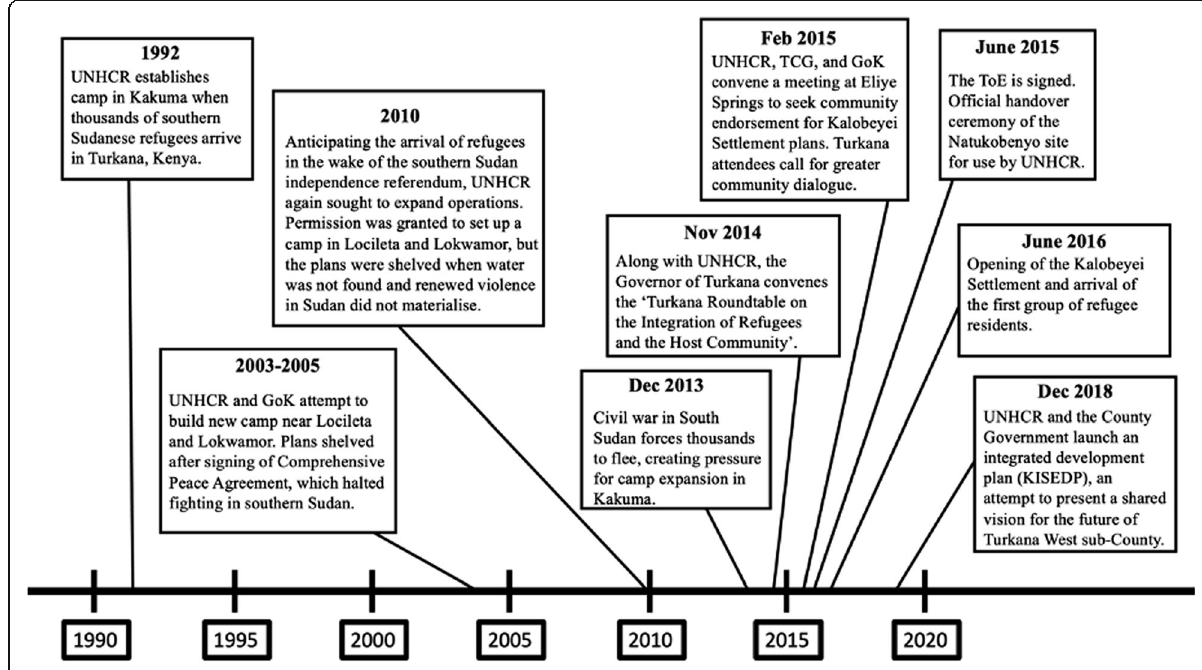
Fig. 2 Timeline of key events in the establishment of the Kalobeyei Settlement. This timeline was assembled based on input from both FGDs and interviews as well as a desk review of relevant reports, especially the Terms of Engagement (discussed below) and the Kalobeyei Settlement Advisory Development Plan produced by UN-Habitat (2018). There is some disagreement with the Terms of Engagement document, which is dated to the opening (February 2015) of a dialogue that lasted multiple months, rather than the date when the agreement was